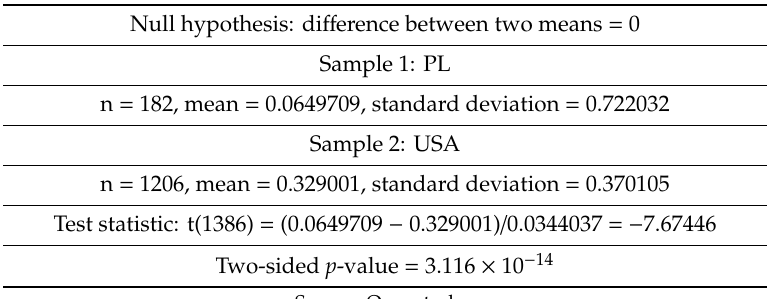
Table 5. Test of di ff erence between mean marketability discount in Poland and